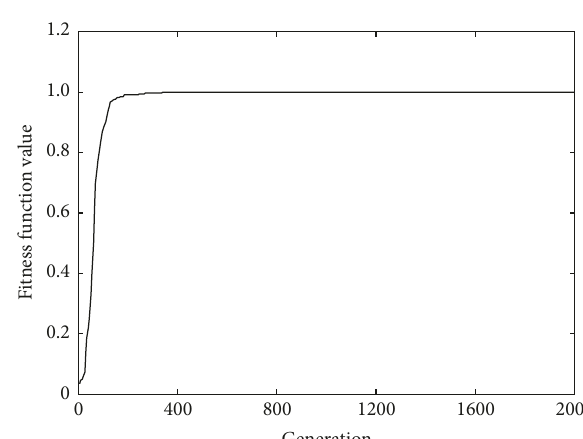
Figure 12: Variation of fitness function value.